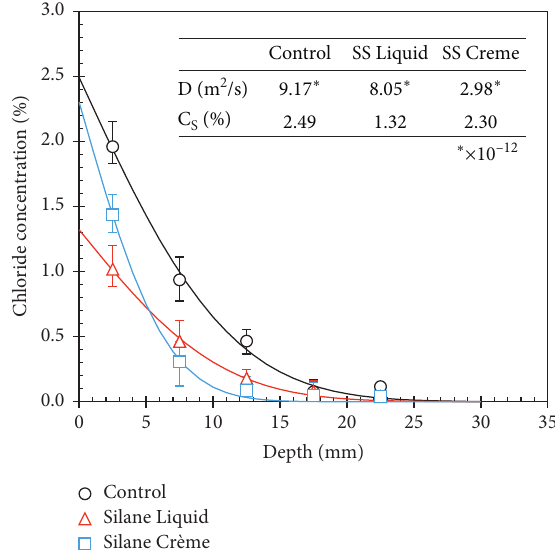
Figure 5: Chloride concentration profiles in concrete for surface